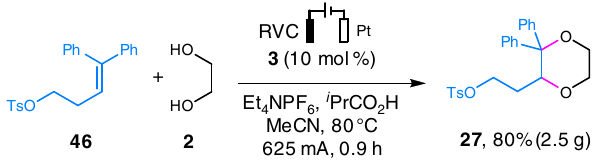
Fig. 2 Electrochemical gram scale reaction. Gram scale synthesis of 27